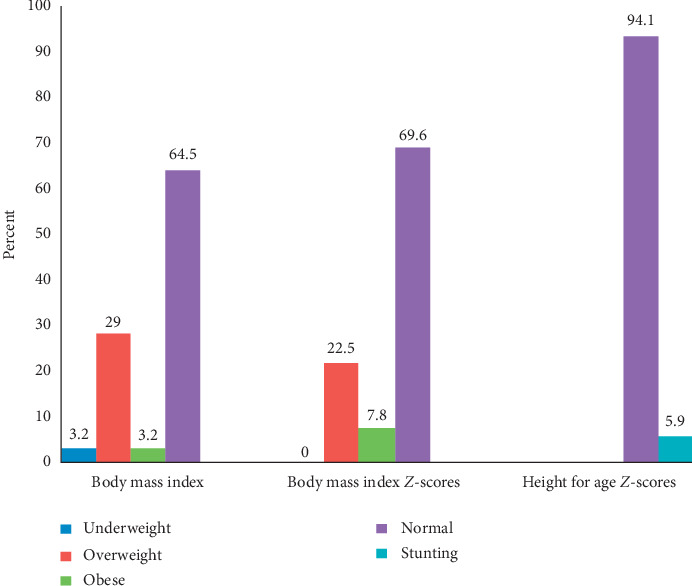
Nutritional status of adolescents. Body mass index, BM1 for age, and height for age Z-score cutoffs for adolescent boys and girls [32].